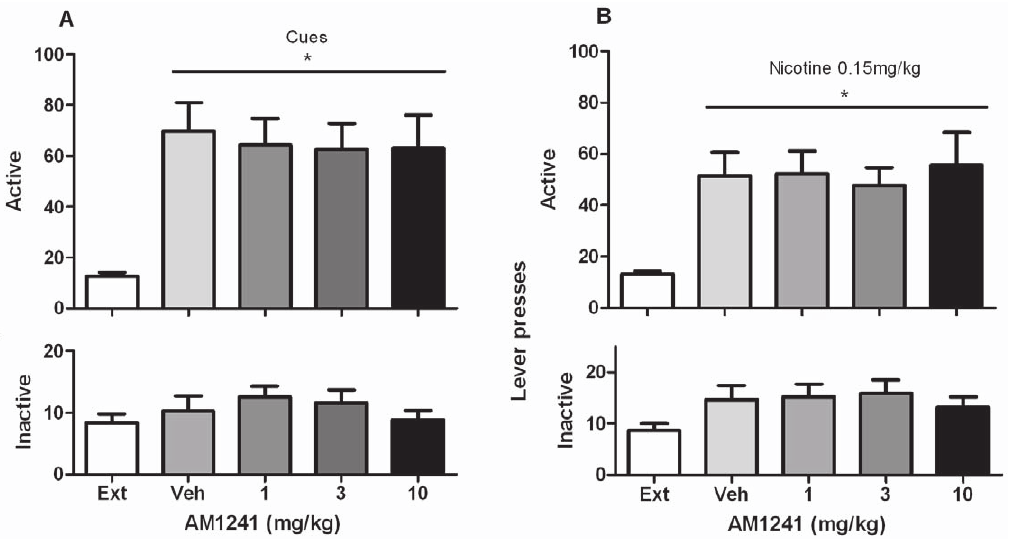
Figure 3. Effects of AM1241 on reinstatement of nicotine-seeking behavior induced by presentation of nicotine associated cues and by Nicotine priming. A . A significant reinstatement of nicotine-seeking behavior was produced by presentation of nicotine associated cues alone compared to extinction condition (Ext) (* P , 0.001). ANOVA showed that pretreatment with AM1241 (1, 3 and 10 mg/kg, IP, H 30 min) did not modify cue induced reinstatement of nicotine-seeking behavior compared to vehicle (0 mg/kg) (P . 0.05) N=11. Data are expressed as means ( 6 SEM) of the number of active and inactive lever presses during extinction (Ext); vehicle (0 mg/kg) pre-treatment (visual cues) and after pretreatment with AM121 (1, 3 and 10 mg). B . A significant reinstatement of nicotine-seeking was produced by pretreatment with nicotine (0.15 mg/kg) compared to extinction condition (Ext) (* P , 0.001). ANOVA showed that AM1241 (1, 3, 10 mg/kg, IP, H 30 min) did not modify reinstatement of nicotine-seeking behavior induced by a priming injection of 0.15 mg/kg nicotine administered 1 min before the session compared to vehicle (0 mg/kg) pretreatment (P . 0.05). Data are expressed as means ( 6 SEM) of the number of active and inactive lever presses during extinction (Ext); vehicle (0 mg/kg) pre- treatment and after pretreatment with AM121 (1, 3 and 10 mg).